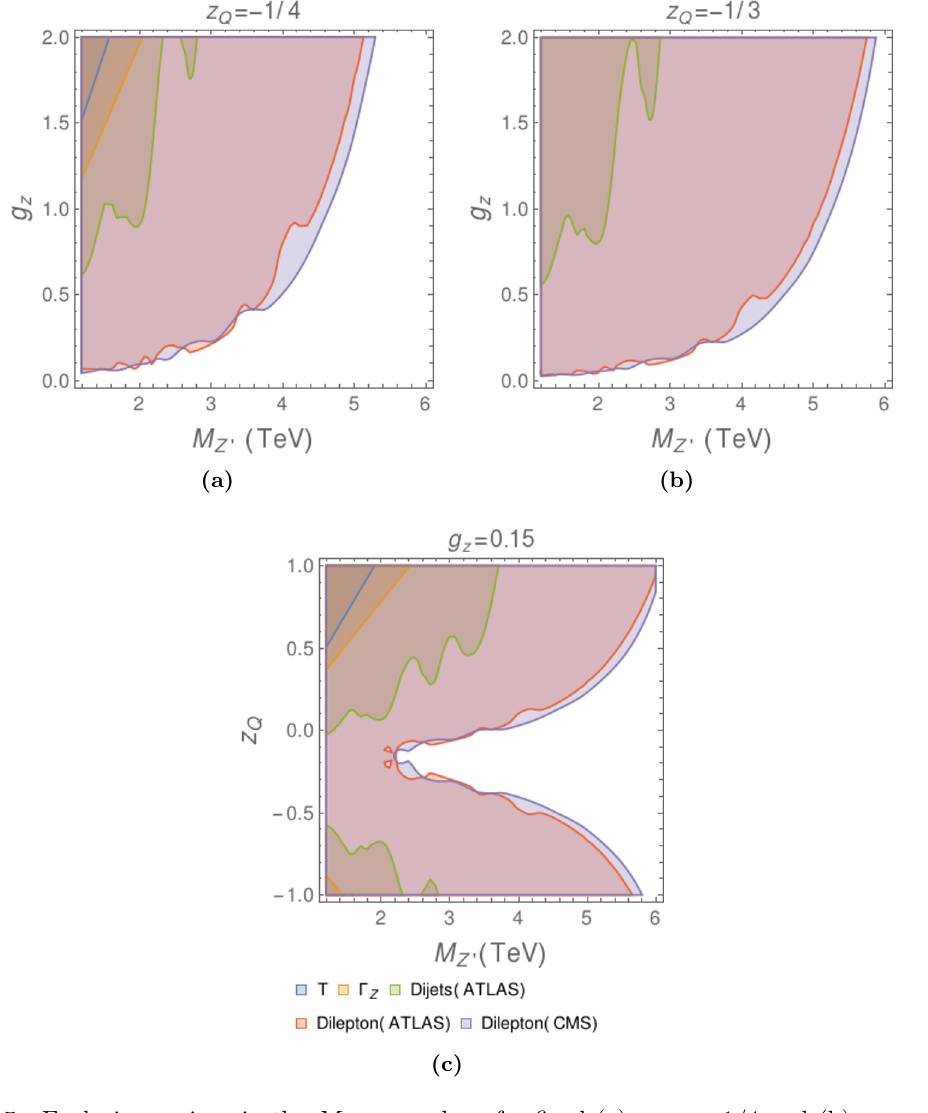
1 = 4 and (b) z Q = 1 = 3 (cid:0) (cid:0)